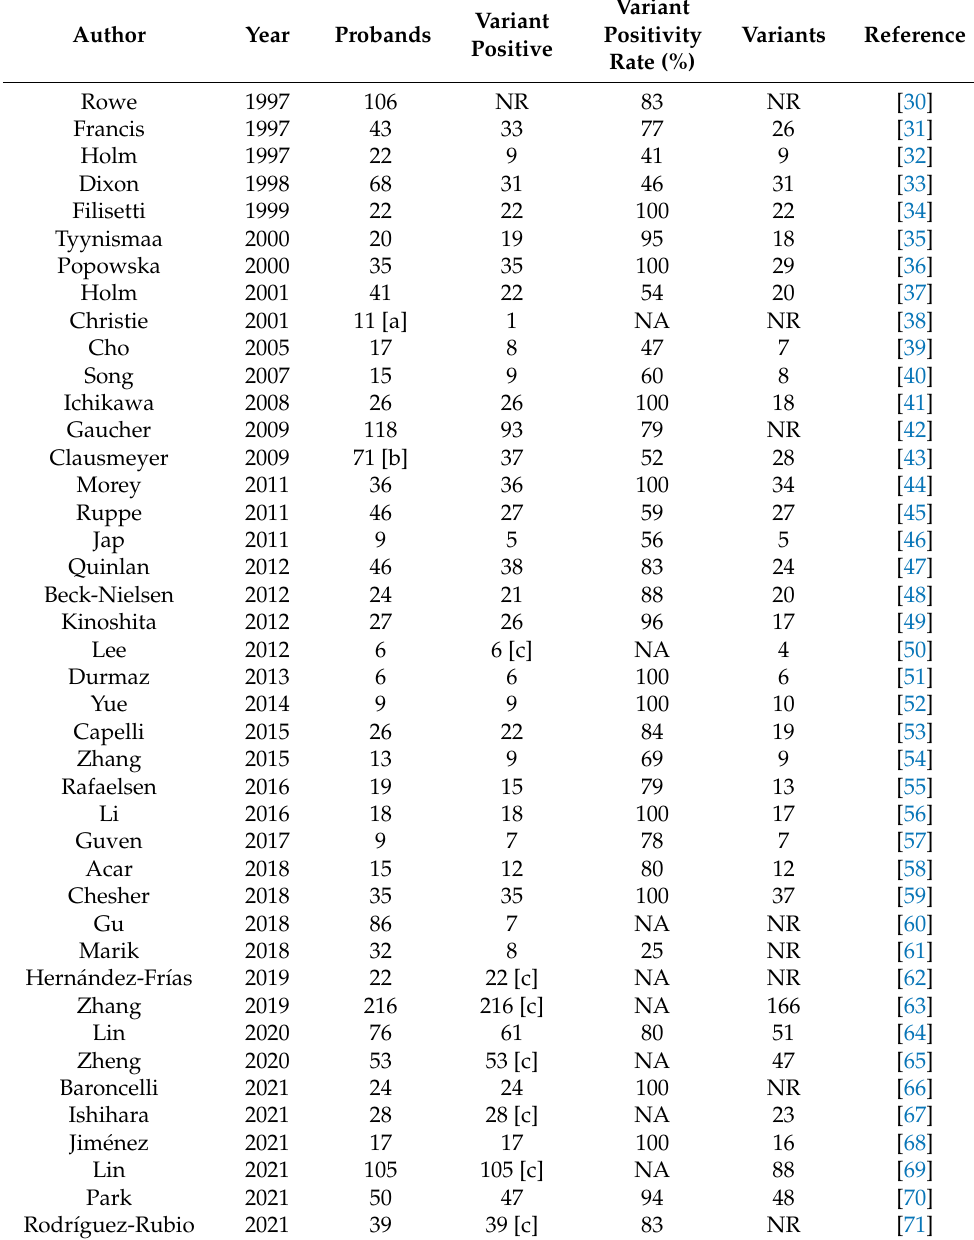
Table 1. List of studies describing PHEX genotypes other than case